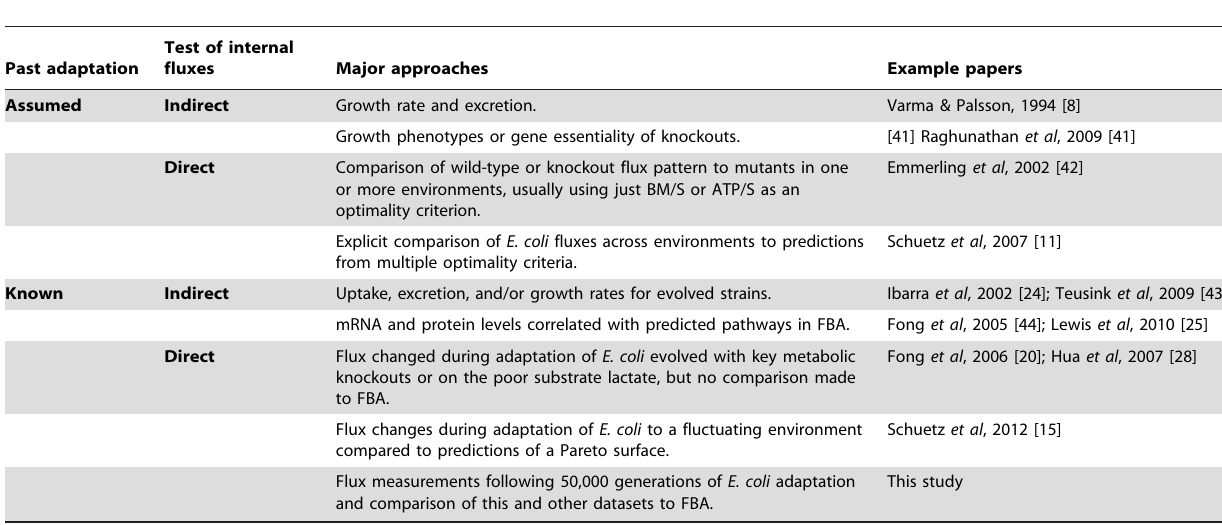
Table 1. Major approaches to test of FBA predictions depending upon whether there was known selection under experimental conditions and whether there was direct measurement of internal